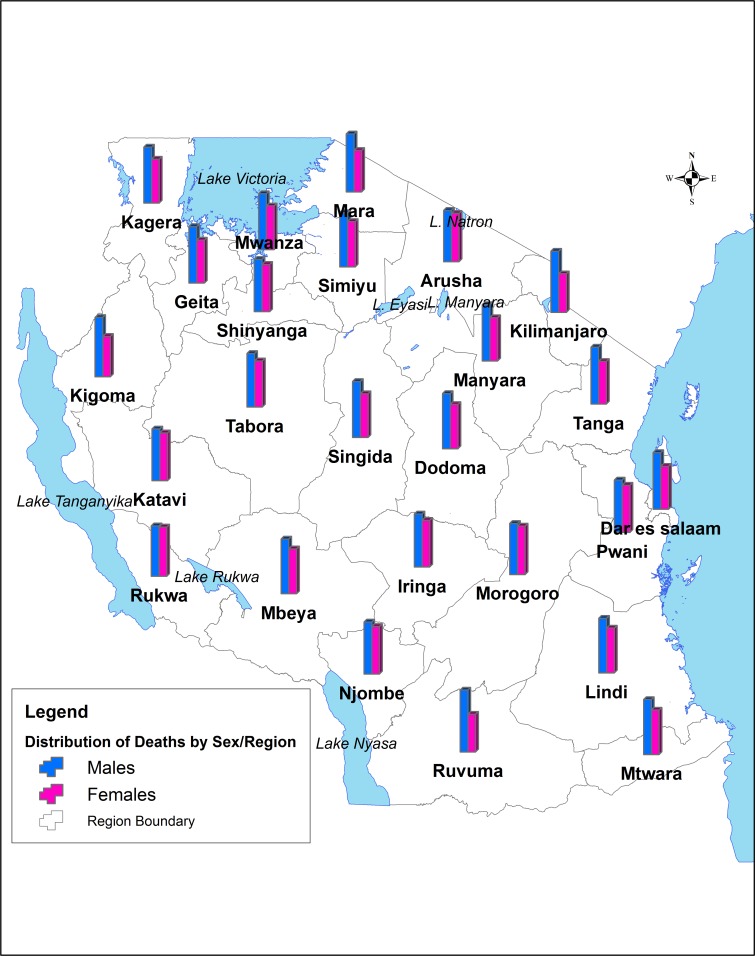
Distribution of death by sex and regions in Tanzania, 2006–2015.